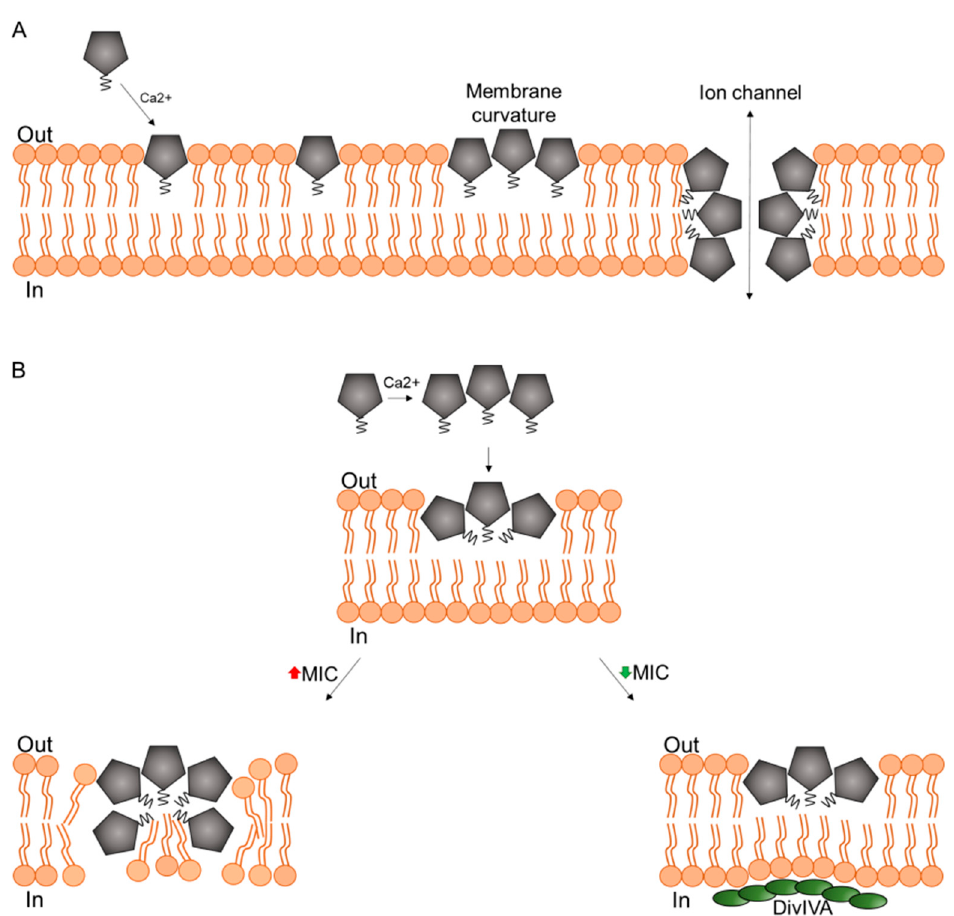
Figure 2. Pore formation model of daptomycin action. ( A ) Original model of pore formation by daptomycin. Adapted from [63]. ( B ) Dual stage model of daptomycin action as proposed by [64].